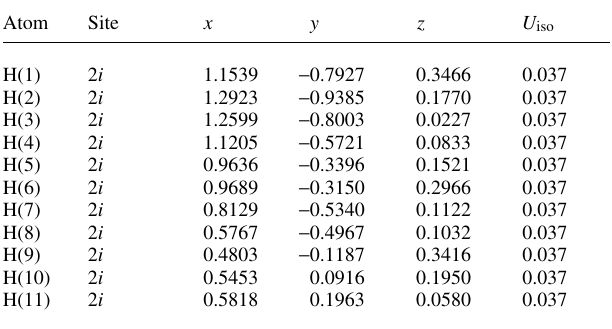
Tab le 2 . A t omi c c oo r din a t e s a nd di s pl ac emen t p a r a me t e rs (in Å 2 )